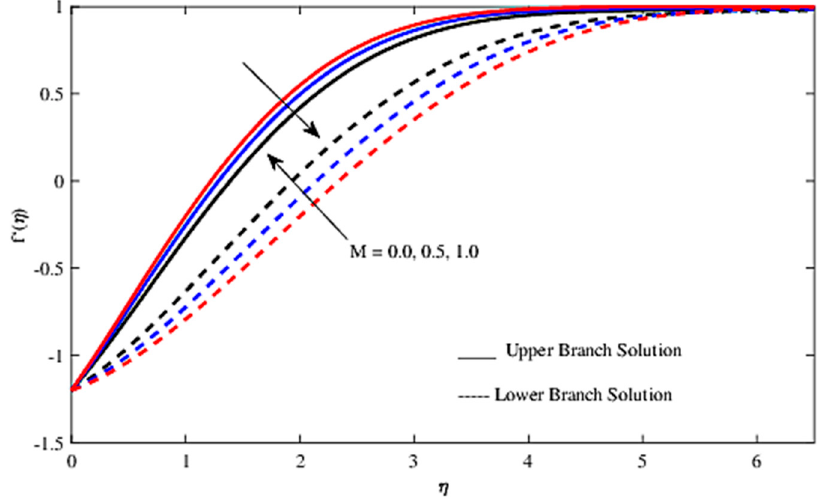
Figure 4. Velocity profiles ( ) f for several values of M when λ = − 1.2, ε = 1000, Q = 0.1 and Pr = 1.0.